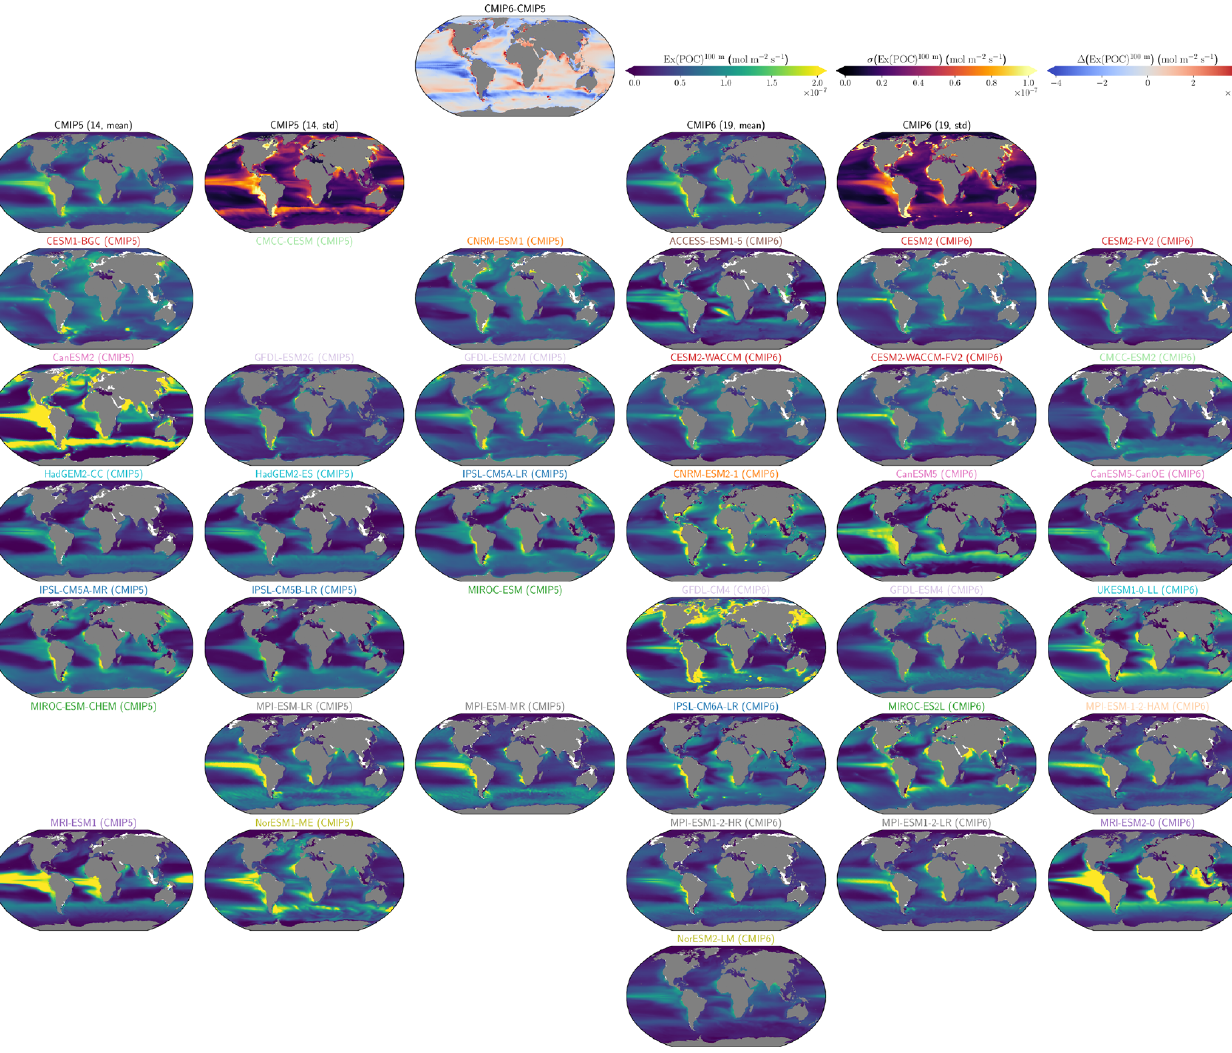
Figure D5. Like Fig. D3 but for the POC export at 100m.